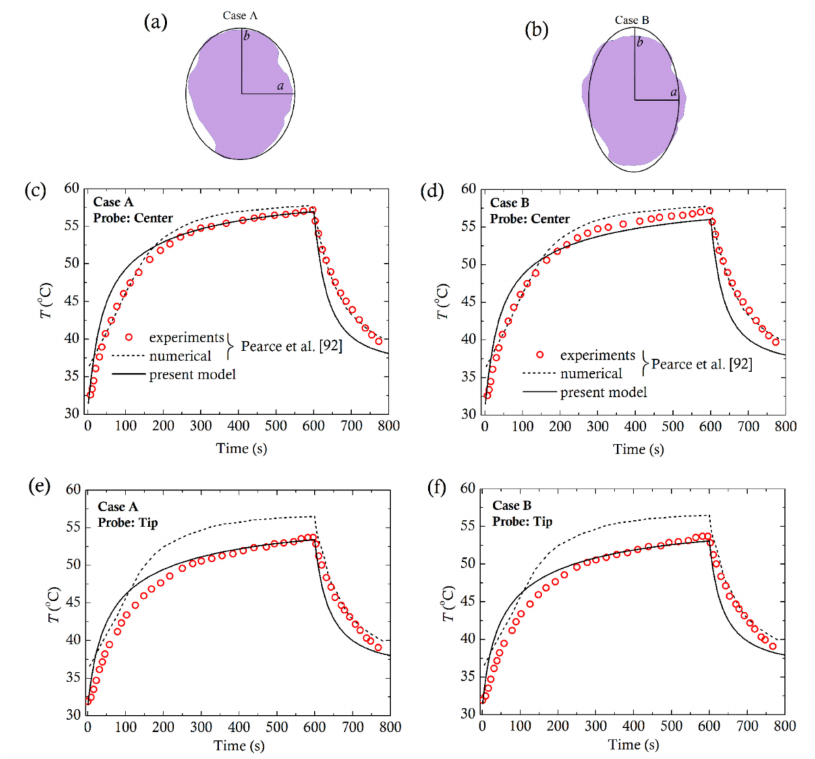
Figure 12. Two cases approximating the tumor shape from a histological cross-section by Pearce et al. [92] with a prolate spheroid. Note that the tumor histological cross-section has been redrawn from the original: ( a ) prolate spheroid shape, case A with AR ≈ 1.29, on top of the re- drawn tumor and ( b ) prolate spheroid shape, case B with AR ≈ 1.57, on top of the redrawn tumor. Comparison of the present numerical model with the 3D numerical model and experiments by Pearce et al. [92] at the tumor center (probe center) for ( c ) Case A and ( d ) Case B and at the probe tip (approximately 3 mm from tumor center) for ( e ) Case A and ( f ) Case